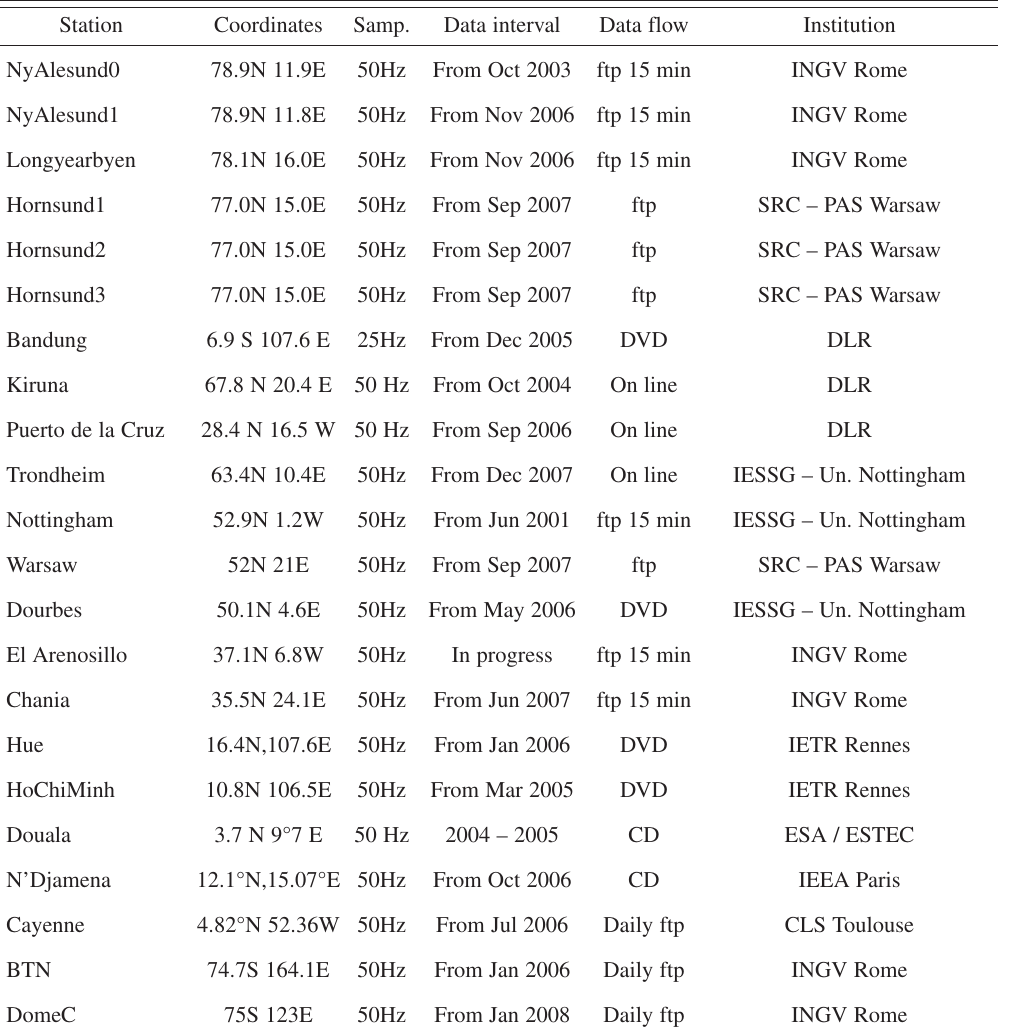
Table I. Monitoring activity of the institutions involved in the COST 296 community.